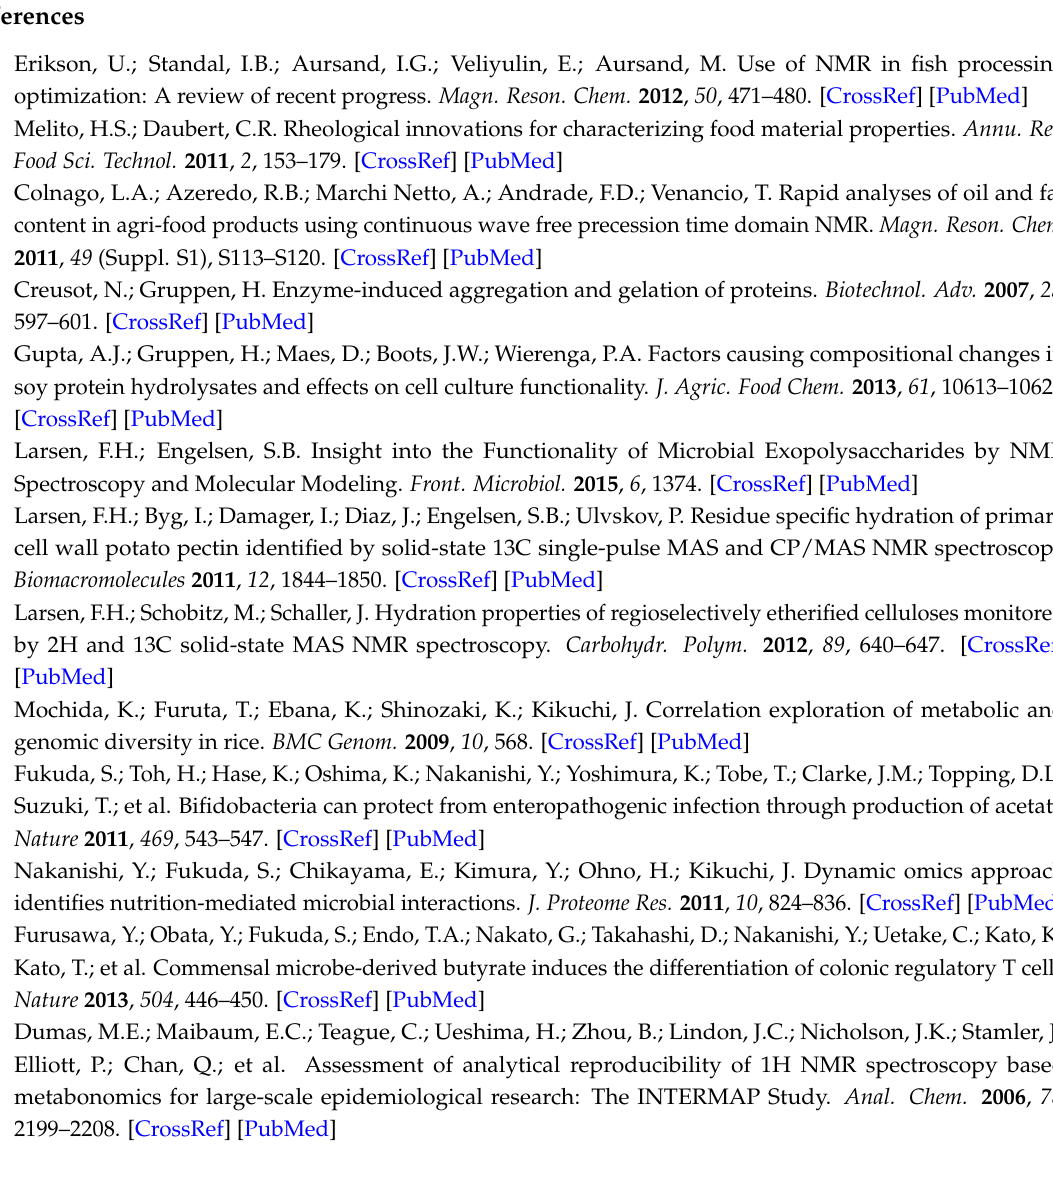
Figure S1: System and entity–relationship diagrams of FoodPro, Figure S2: Typical CDCl 3 experimental NMR spectra deposited in FoodPro, Figure S3: (a) PCA score plot for PC1 and PC2 with CDCl 3 spectra. Note that symbol names represent broad types of processed foods such as fermented or cooked (e.g., Fish g means a fish group.) (b) PCA loading plot for PC1 (blue) and PC2